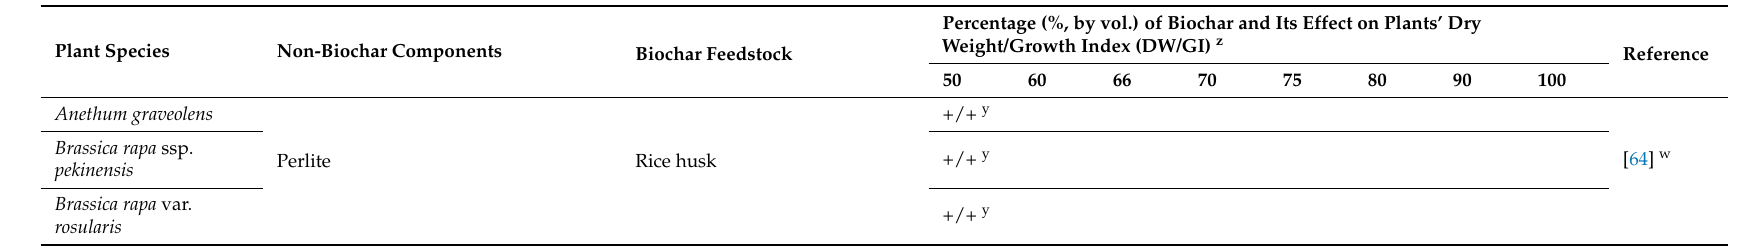
Table 3. Summary of the effects of biochar made from different feedstocks mixed with other substrate components on container-grown plants, with percentage of biochar in container substrates ranging from 50% to 100% (by